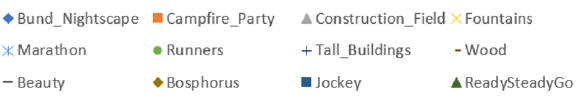
Figure 8. The legend of Figures